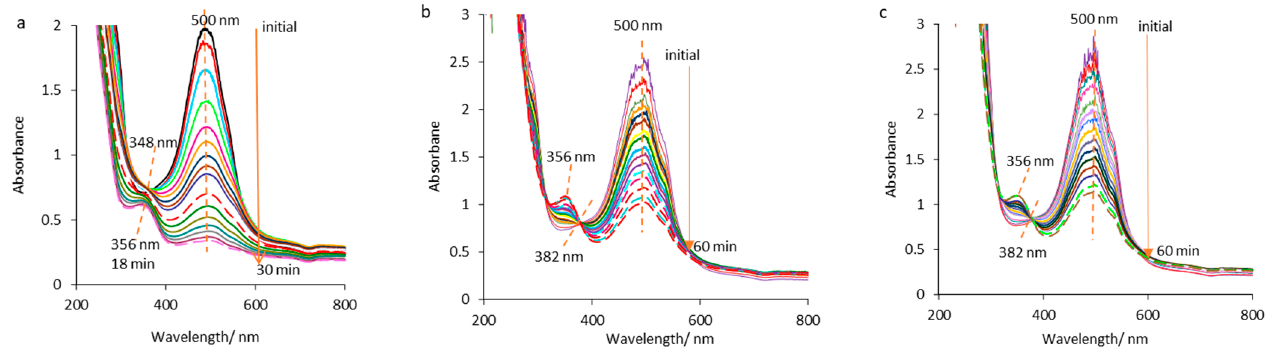
Figure 1. Epirubicin UV-Vis spectra recorded during electrolysis at a constant current density of 50 mA cm − 2 : ( a ) in aqueous HCl solution (EPR_HCl); ( b ) in supporting electrolyte, in the absence of essential oil (EPR_SE); ( c ) in supporting electrolyte, in the presence of essential oil (EPR_ESO).